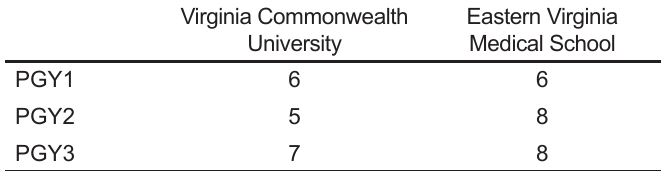
Table 1. Training year and institution distribution of emergency medicine residents who participated in a transesophageal echocardiography simulation study.